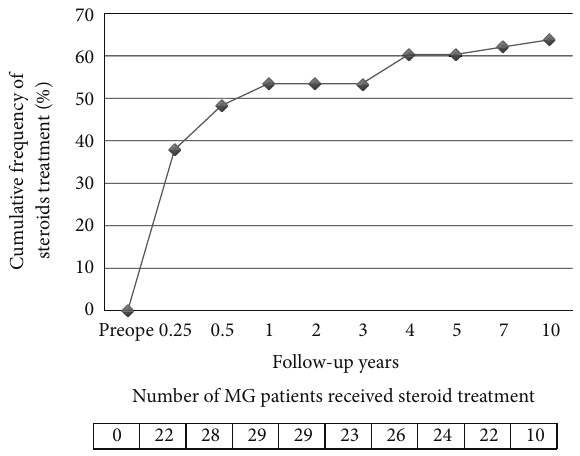
Figure 4: We show cumulative frequency of steroid treatment in the no preoperative steroid group after thymectomy during follow-up period. The life table analysis of steroid treatment started at zero. And we show the number of MG patients who received steroid treatment,atwhichtimeinthecourseoftheirdiseasesatthebottom.